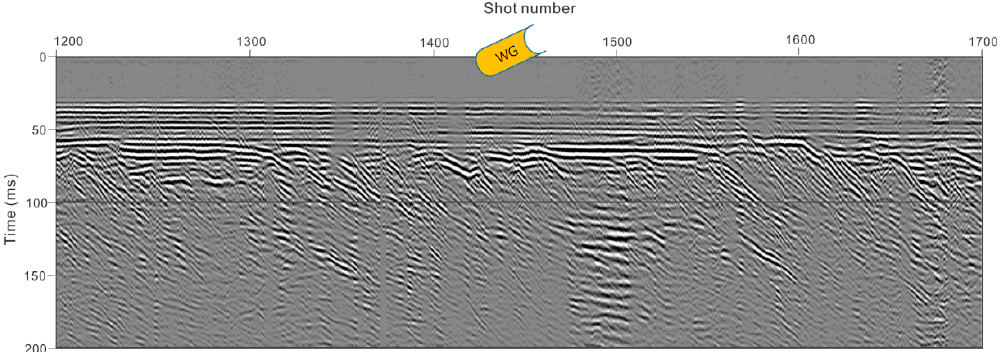
Figure 9. Single-channel-recorded sections after processing.